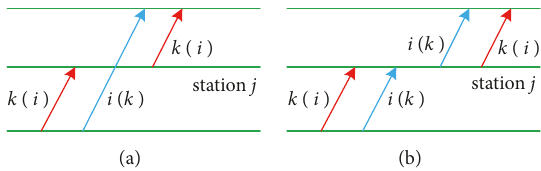
Figure 3: The constraints for overtaking between train services at the station. (a) The “stop-pass” pattern. (b) The “stop-stop” pattern.